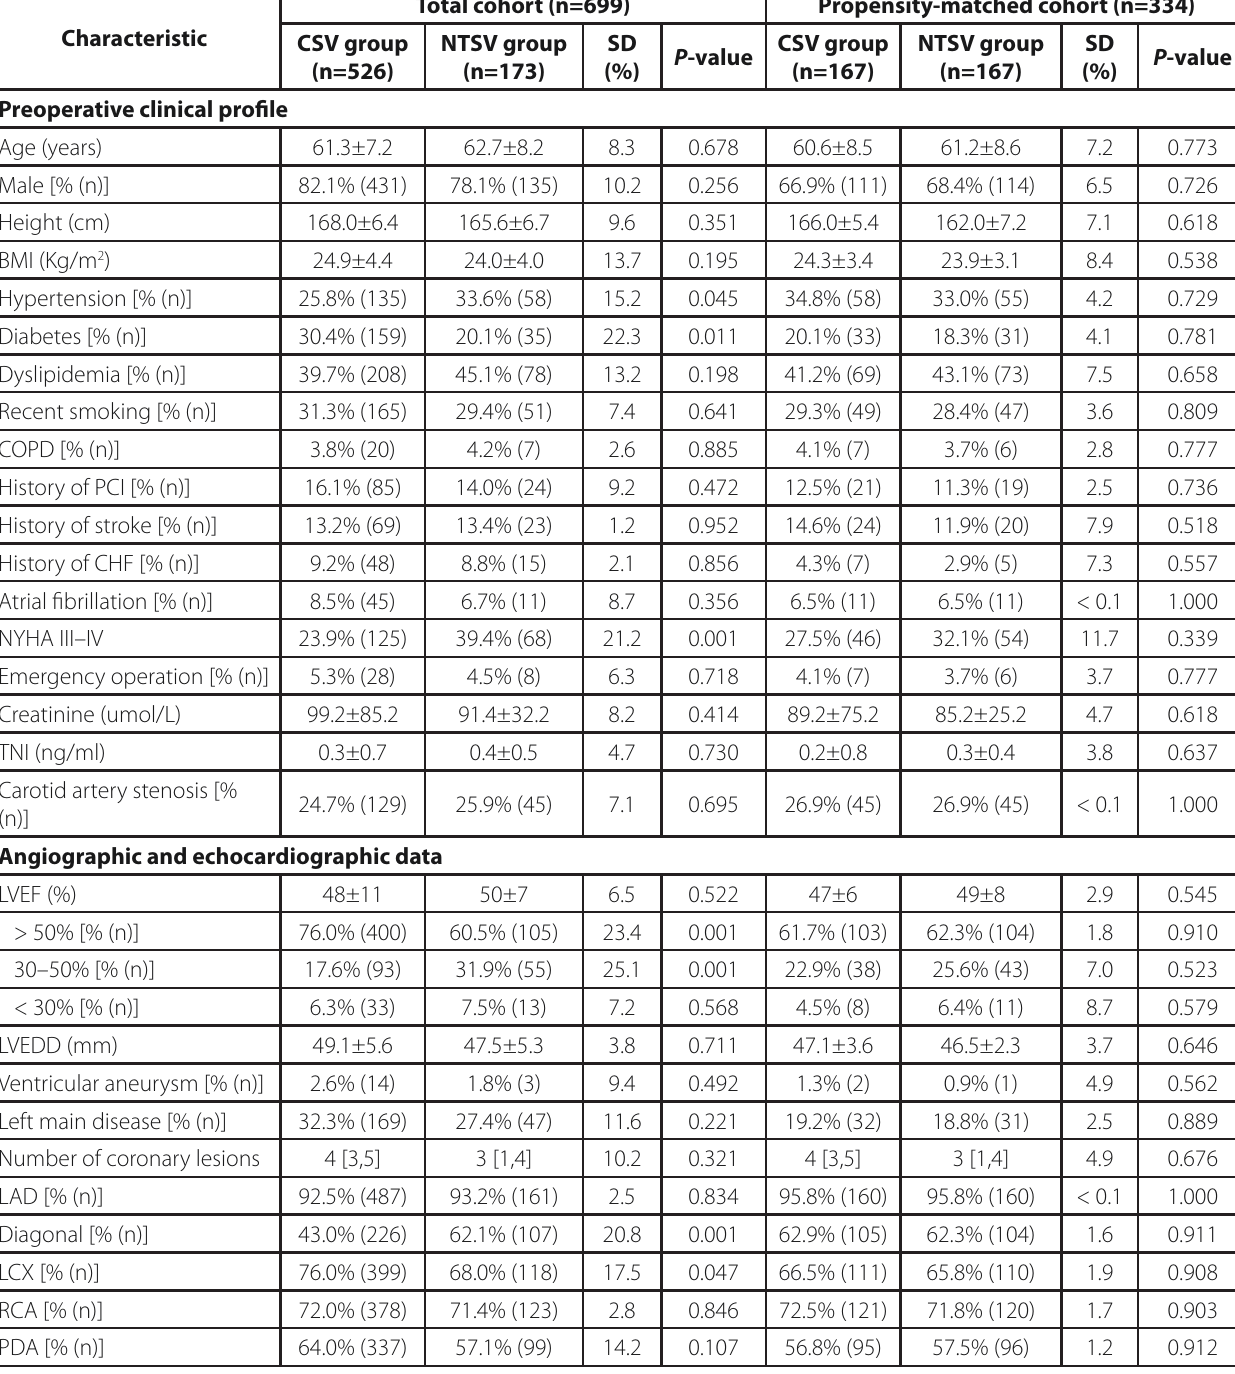
Table 1. Preoperative characteristics of total cohort and propensity-matched cohort.